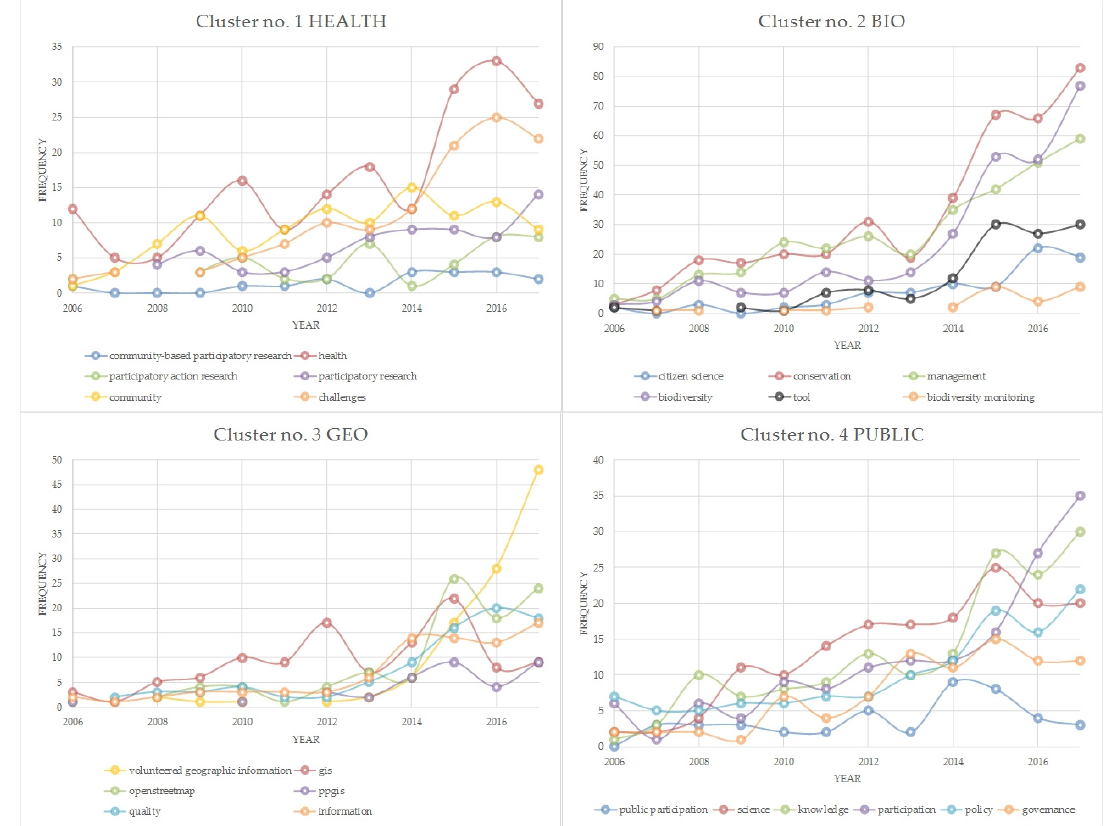
Figure 7. Variations in the most frequent terms by cluster.